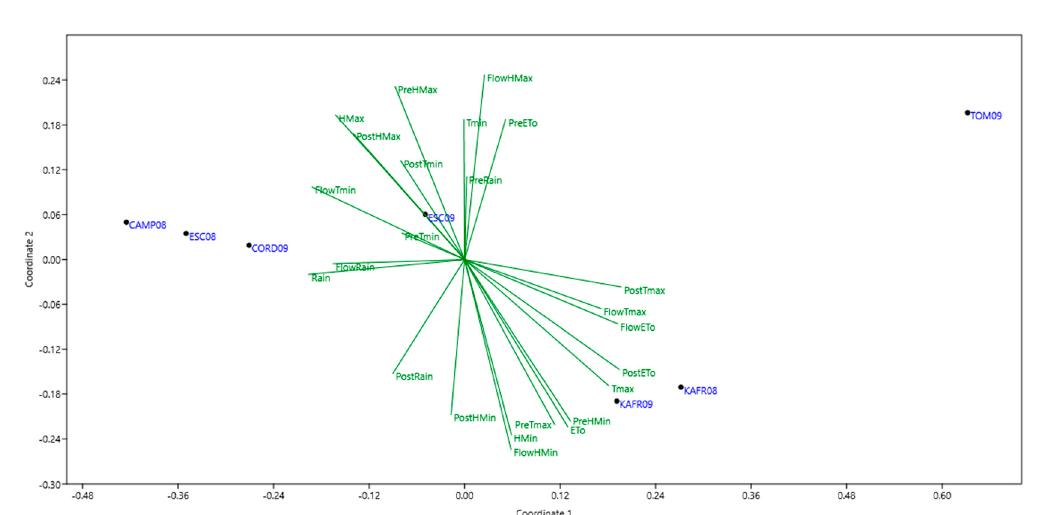
Figure 1. Non metric multidimensional scaling (NMDS) analysis of climate variables including: maximum temperature (Tmax), minimum temperature (Tmin), maximum humidity (Hmax), minimum humidity (Hmin), Evapotranspiration (ETo) and rain during different growing stages [pre-flowering (Pre), flowering (Flow), post-flowering (Post) and complete growing season] characterizing the seven environments, used for phenotyping grain yield.